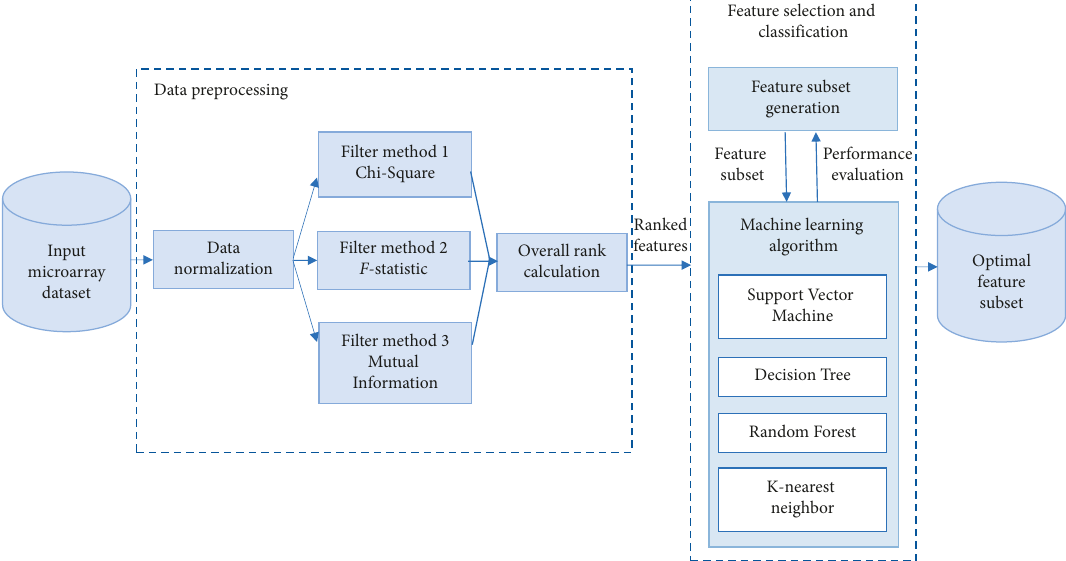
Figure 1: Proposed cancer prediction